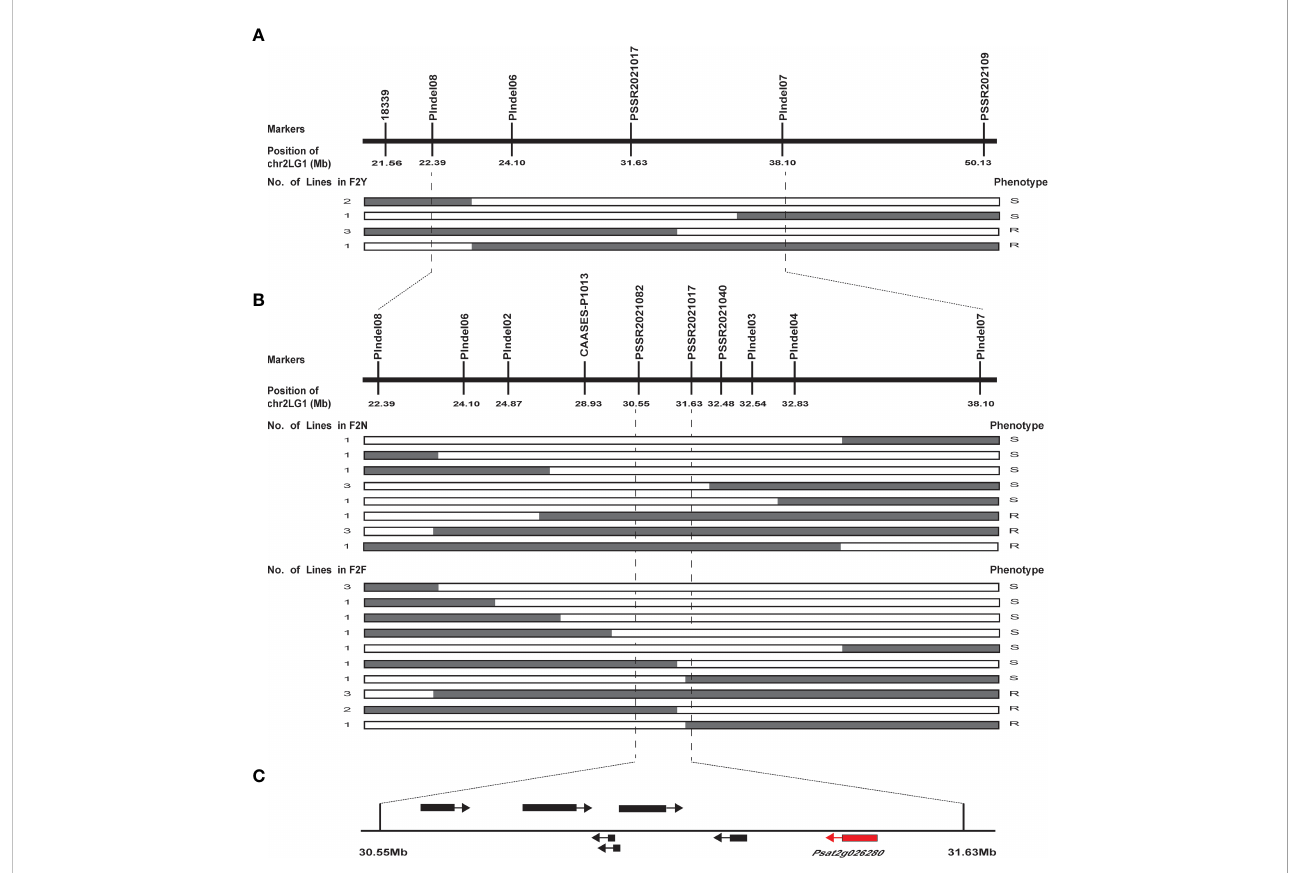
FIGURE 4 Fine mapping of qPsBr2.1 controlling seed resistance to C chinensis and C maculatus in fi eld pea cultivar PWY19. (A) qPsBr2.1 is mapped onto pea chromosome 2 between the InDel markers PIndel08 and PIndel07 using the F 2 population F2Y. The numbers under the markers represent the positions of the markers on chromosome 2. (B) qPsBr2.1 is narrowed down to marker interval PSSR2021082 – PSSR2021017 using the F 2 populations F2N and F2F. White and gray boxes in the recombinants indicate homozygous genotype of the susceptible parent and heterozygous genotype, respectively. (C) A 1.07